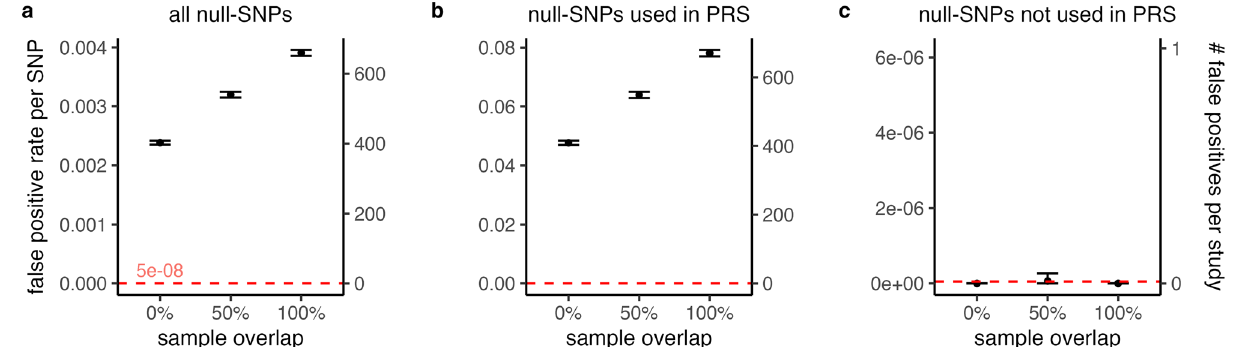
Figure 1. Inflated false positive rates in GWAS of PRS-derived phenotype. The false positive rates (a–c) are displayed for varying degrees of sample overlap between discovery and target cohort in a GWAS of a PRS- derived phenotype. Across 100 simulation runs, we observe highly inflated false positive rates. For all null-SNPs, the mean false positive rate ranges between 0.0024 (0% overlap) and 0.0039 (100% overlap) at a significance threshold of 5 × 10 –8 (a) . Null-SNPs used to construct the PRS-derived phenotype show the highest inflation (b) , while all other null-SNPs do not show any inflation (c) . As such, the inflation in all null-SNPs is driven by SNPs used to construct the PRS-derived phenotype. Increasing overlap between the target and discovery cohort exacerbates the inflation. We additionally plot the number of false positive associations per study (i.e. false positive rate per SNP times the number of SNPs considered). The mean number of false positives ranged between 402 and 659, and is driven by null-SNPs used to construct the PRS-derived phenotype. The error-bars show the 99.9%-confidence interval of the mean. See Supplementary Table for descriptive